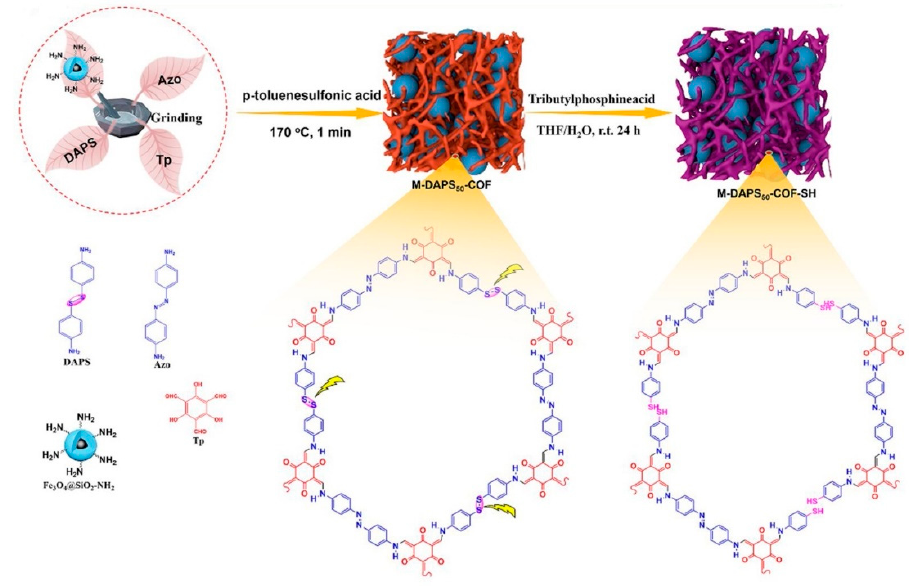
Figure 17. Schematic diagram for the synthesis of Fe 3 O 4 / DAPS-SH composite (reproduced with permission from reference [89], copyright 2020, Elsevier).